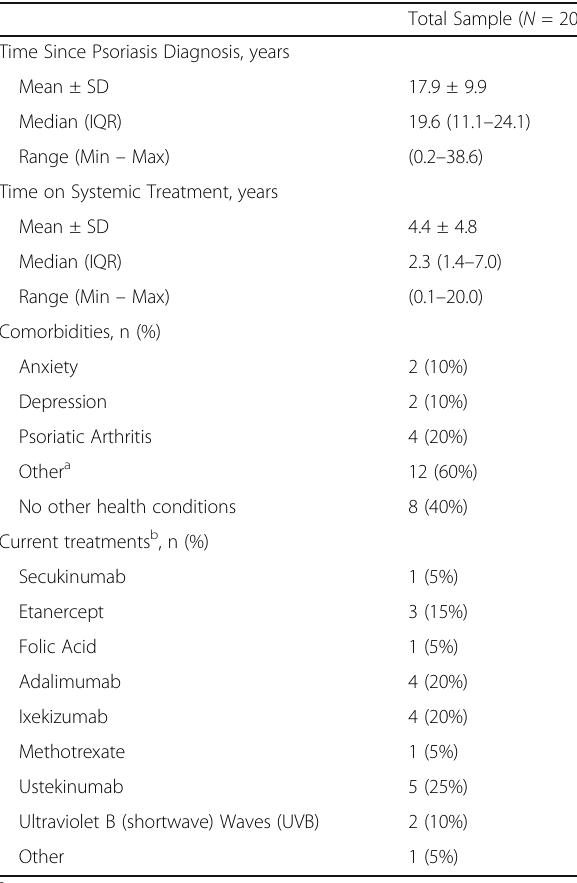
Table 2 Clinician-Reported Participant